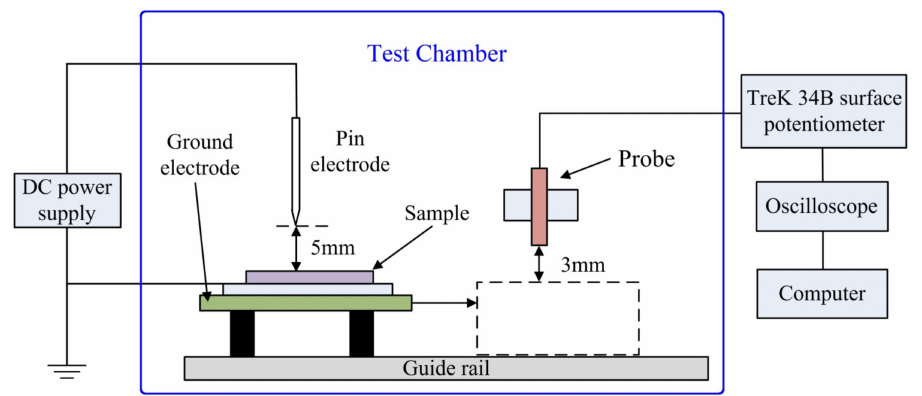
Figure 1. Schematic test system of isothermal surface potential